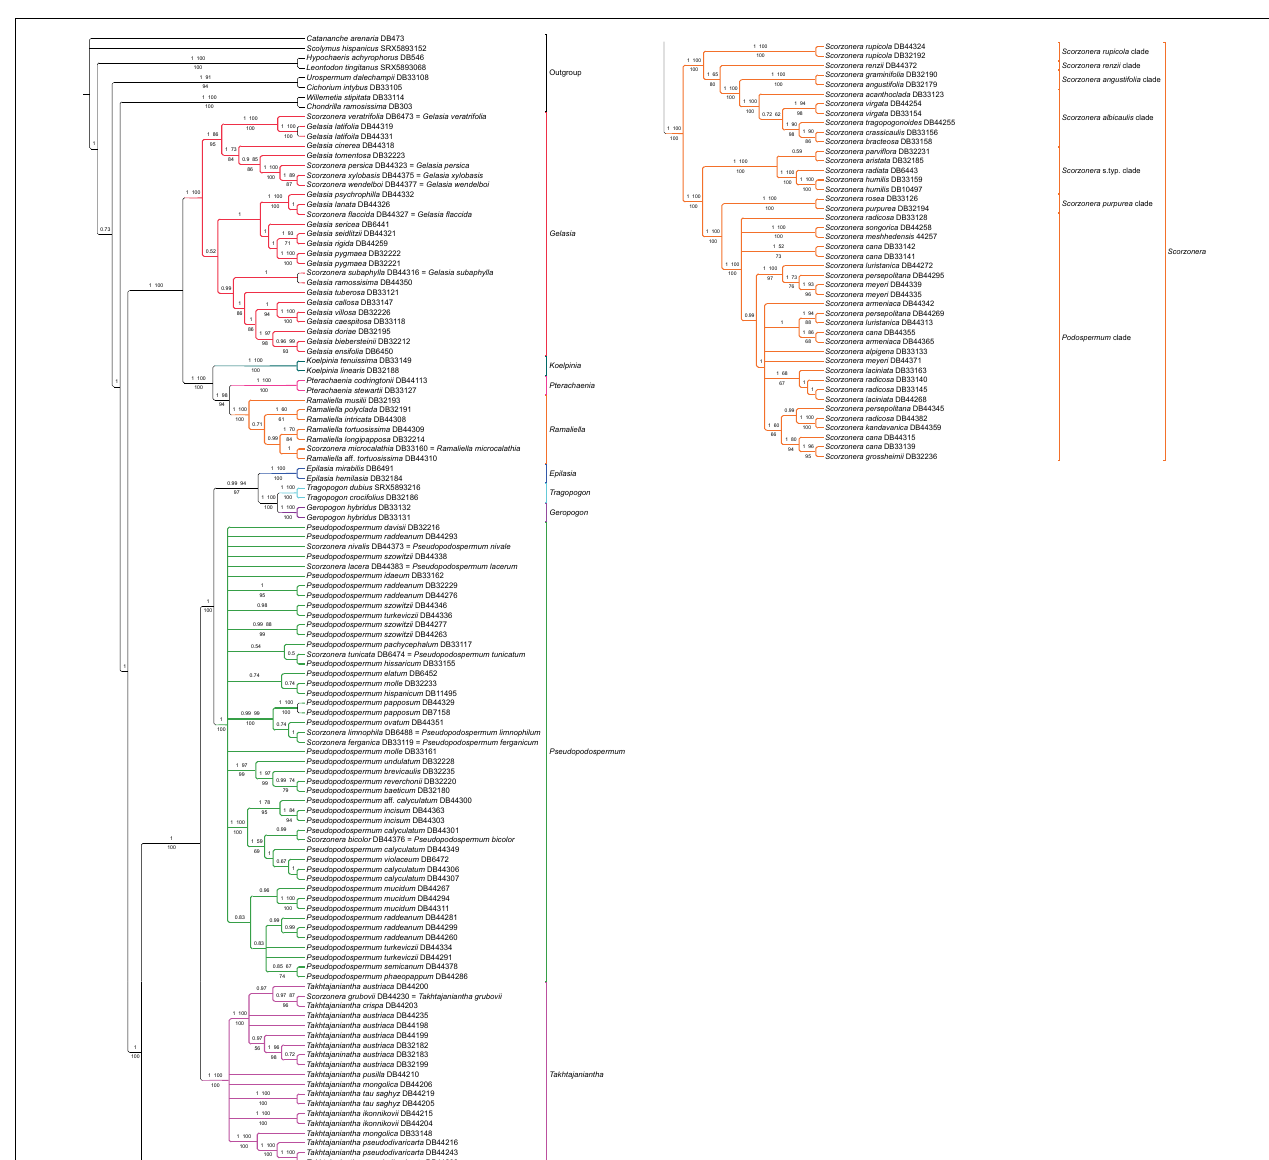
FIGURE 5 | Phylogenetic reconstruction of subtribe Scorzonerinae inferred with OLS dataset under the concatenation approach. Branch labels above the branches indicate posterior probabilities (PP) of Bayesian analysis and bootstrap values of ML no-partitioned analysis (BS-NP) and below the branches, bootstrap values from ML partitioned analysis (BS-P). Branches with less than 0.5 PP and 50% bootstraps (BS-NP and BS-P) are collapsed.